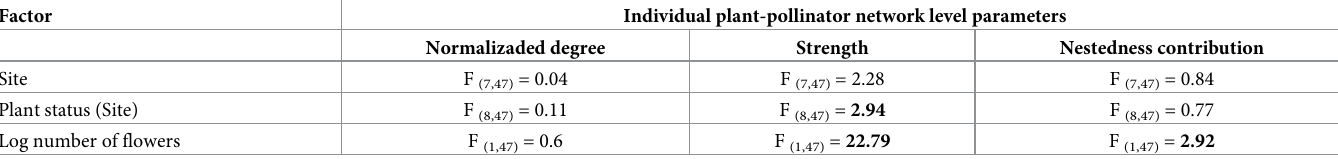
Table 3. Results of mixed models evaluating differences in species-level plant-pollinator network parameters. Floral abundance (log number of flowers) was included as a covariate. Significant effects are shown in bold (p �